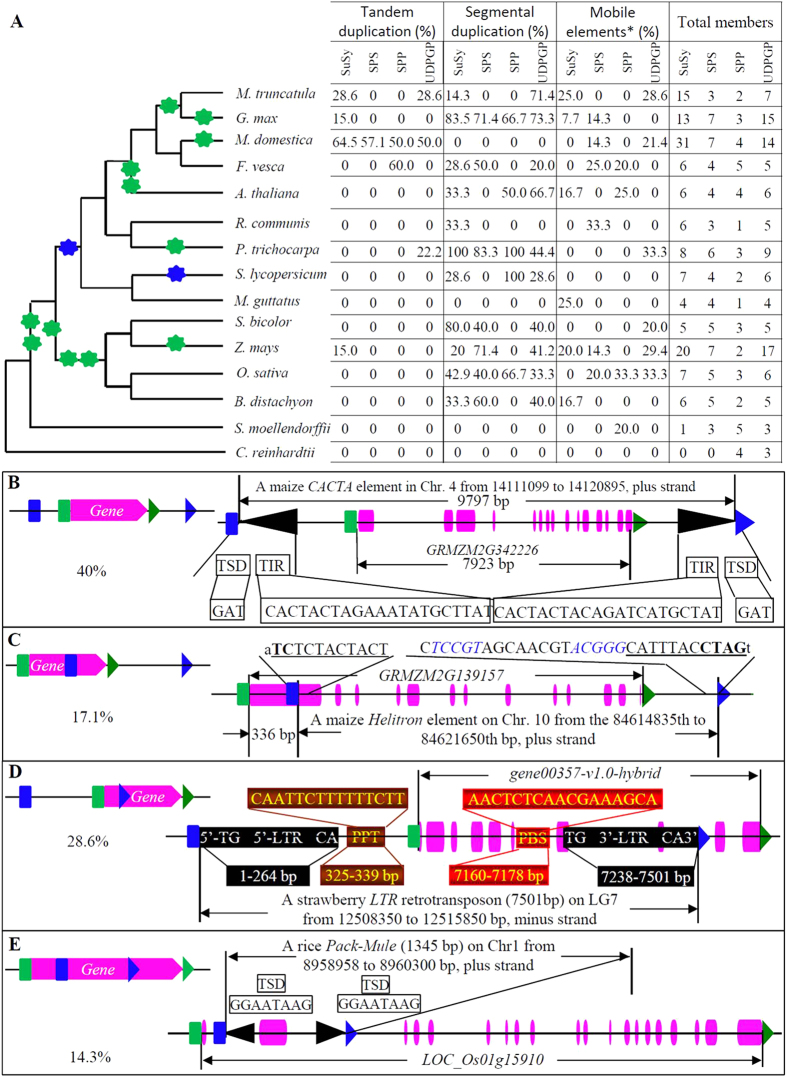
Expansion mechanisms of the SuSy, SPS, SPP and UDPGP families in 15 plants.(A) The phylogenetic tree in left panel was constructed according to the plant genome duplication database (http://chibba.agtec.uga.edu/duplication/) and showed the whole genome duplication history of 15 species. Green and blue stars indicate whole genome duplication and triplication, respectively. Columns in right panel in (A) indicates the contributions of tandem, segmental duplications and mobile elements to the expansion of the SuSy, SPS, SPP and UDPGP families in 15 genomes. The last column showed the summary of all identified family members in 15 species. The star “*” indicates mobile elements including LTR-retrotransposon, retrogene, Pack-Mule, hAT, Helitron and CACTA elements. Figures (B–E) show different types of expansion of family members by transposition. (B) A whole gene fragment was duplicated (type 1). A maize gene GRMZM2G342226 was expanded by a CACTA element in chromosome 4, which was characterized with typical CACTA structures. TSD, target site duplication; TIR, terminal inverted repeat. (C) Only 3′-region of a gene was duplicated (type 2). The 3′-region of a maize gene GRMZM2G139157 was duplicated by the Helitron element on chromosome 10 with typical Helitron features. The Helitron begins with “TC” and ends with CTAG, which were conserved sequence motifs (indicated by bold uppercase letters). These two motifs form parts of 11 bp palindromic sequences (underlined). Helitron sequences are in uppercase letters and the invariant host nucleotides where the Helitrons insert are in lowercase letters. The inverted repeats at the 3′ termini are in blue fonts. The 336 bp fragment is the duplicated gene fragment. (D) The 5′-region of a gene was duplicated (type 3). The strawberry gene gene00357-v1.0-hybrid was duplicated by a LTR-retrotransposon. The figure indicates structural features of this retrotransposon including 5′- and 3′-LTR, both of which start with TG and end with CA. Both PPT (polypurine tract) and PBS (primer binding site) are also indicated. (E) The middle region of a gene was duplicated (type 4). The middle region of a rice gene LOC_Os01g15910 was duplicated by a rice Pack-Mule on chromosome 1. TSD, target site duplication.